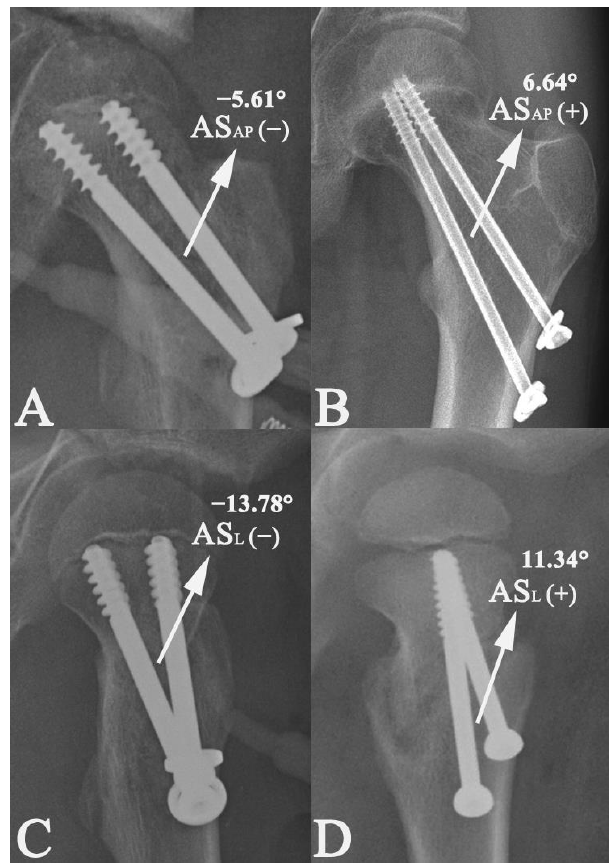
Figure 2. The angulation (AS) between the axis of two cannulated screws on anterior – posterior (AS AP ) and lateral (AS L ) radiographs were both measured and were expressed as degrees (°). The value of AS AP or AS L was defined as neutral (zero) if two screws were parallel, negative if two screws were divergent ( ˅ -shape), and positive if two screws were convergent ( ˄ -shape) ( A – D ). Whether the fracture fragments were fully or partially compressed by the PTCSs was evaluated according to the location of the screw threads in relation to the fracture site. The fracture fragments were considered fully compressed if all of the threads were above the fracture line (within the proximal fragment) on the AP and lateral postoperative radiographs (Figure 2). If one or more of the threads were at the level of the fracture line or below the fracture line on either AP or lateral radiographs, the fracture fragments were defined as partially compressed (Figure